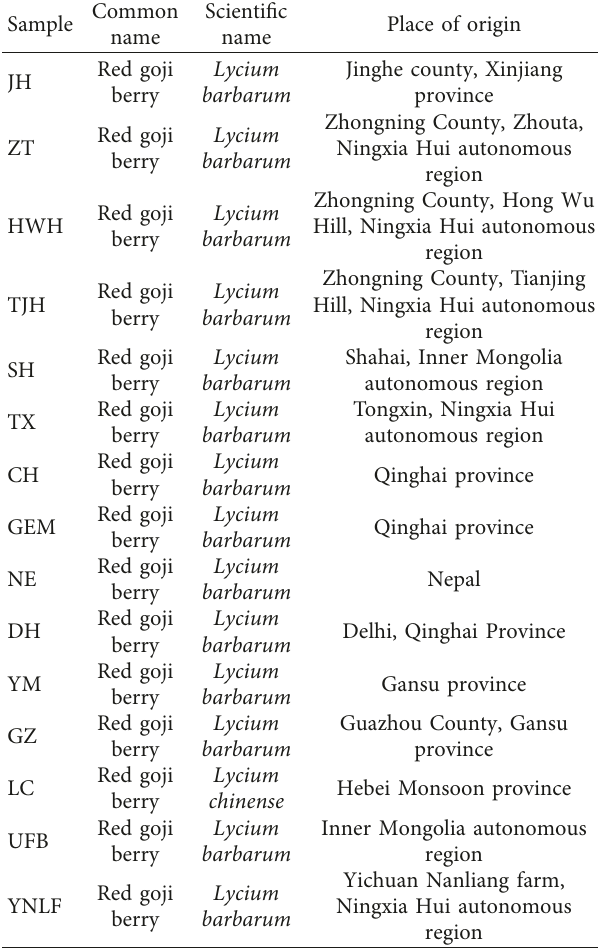
Table 1: Sample information of the goji berry